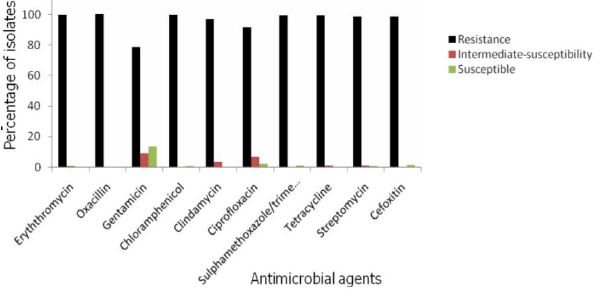
Fig. 1. Antibiogram of methicillin (oxacillin) resistant staphylococcal isolates from